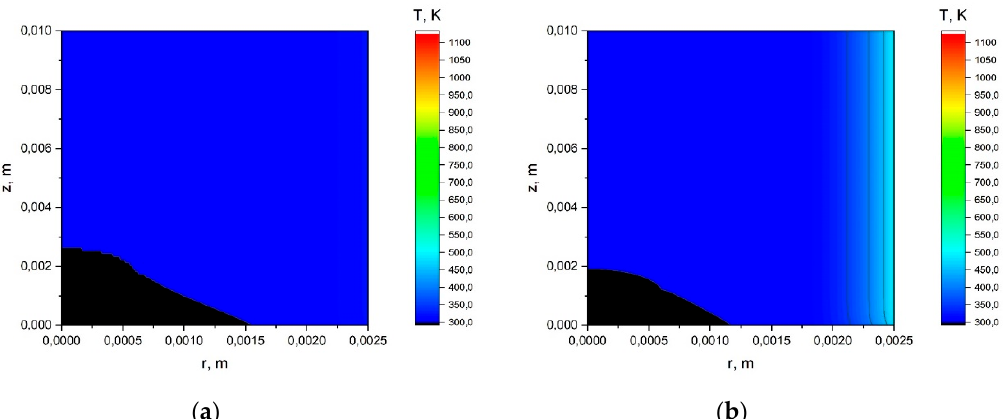
Figure A6. Temperature distribution in the stem of a herbaceous plant: R = 0.0025 m, t = 0.5 s, q = 3 kW/m 2 ( a ); R = 0.0025 m, t = 0.5 s, q = 30 kW/m 2 ( b ).